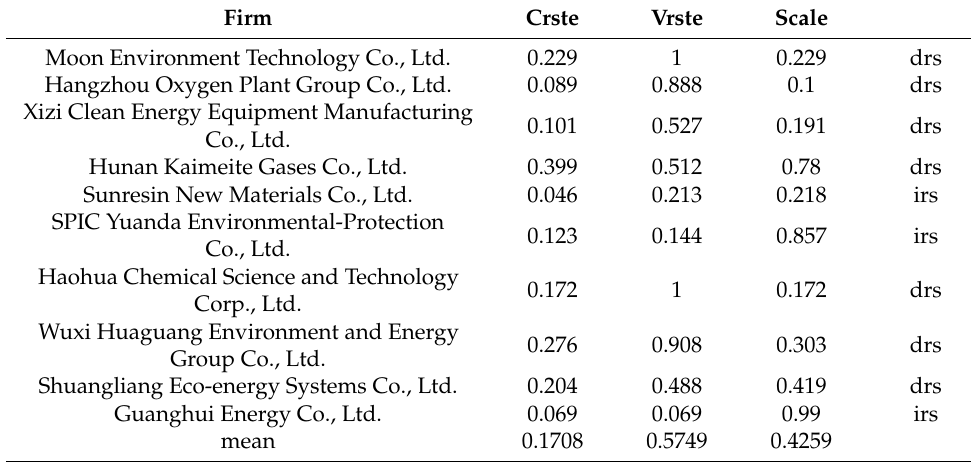
Table 5. 2020 Enterprise Data.